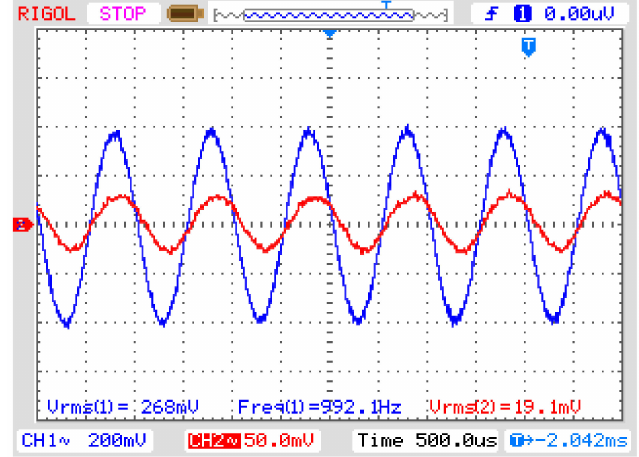
Figure 16. OVT input (CH1) and output (CH2) voltage for a 1 kHz sine wave. Vertical axis: 200 mV/div (CH1) and 50 mV/div (CH2), Horizontal axis: 500 µ s/div.